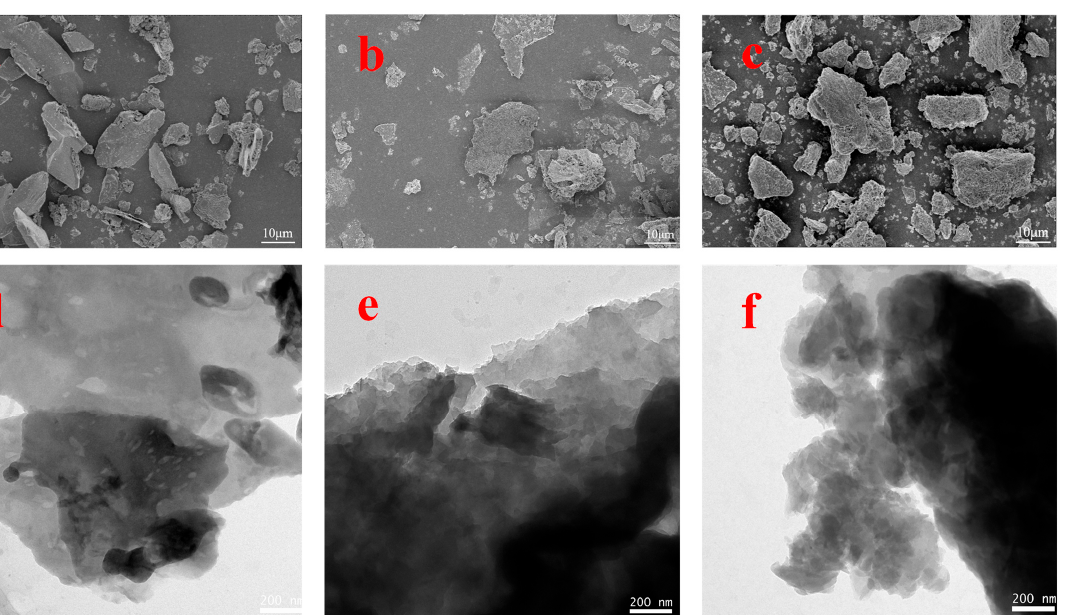
Figure 2. SEM images of g-C 3 N 4 ( a ), CNK-OH ( b ), Co-CNK-OH ( c ) and TEM images of g-C 3 N 4 ( d ), CNK-OH ( e ), and 9%Co-CNK-OH ( f ). To con fi rm the elemental distribution, the EDS and elemental mapping images of the Co-CNK-OH are shown (Figure 3a–g). It was obvious that the surface of the g-C 3 N 4 was smooth while the surface of the CNK-OH became rougher with dispersed particles after the alkalization treatment (Figure 2a, b), which may have been due to the in fl uence of the grafted hydroxyl group on the surface of the g-C 3 N 4 [33]. Compared with the CNK-OH and g-C 3 N 4 surfaces, smaller solid particles were observed, and the surface of the Co- CNK-OH was much rougher after the Co 2+ modi fi cation (Figure 2c). From the microstruc- ture of the CNK-OH, numerous nanosheets on the surface could be clearly seen (Figure 2e). However, the modi fi cation with Co 2+ resulted in a more fragmented and uniformly dispersed nanosheet structure, in agreement with the SEM analysis results (Figure 2e, f). As for Co-CNK-OH, it was clear that C, N, O, K, and Co were uniformly distributed on the surface of the Co-CNK-OH material in Figure 3c–g, and the previously mentioned evidence implied the formation of Co-CNK-OH heterojunctions at the microscopic level.